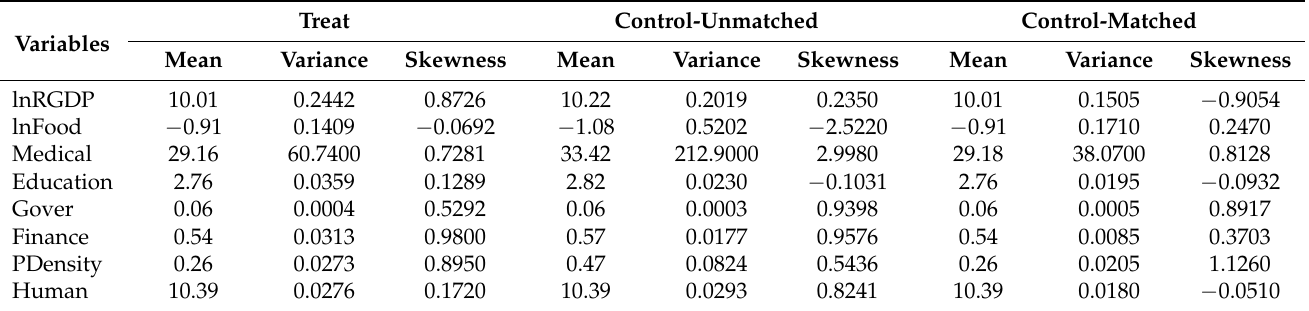
Table 5. Comparison of covariates before and after entropy balancing matching.